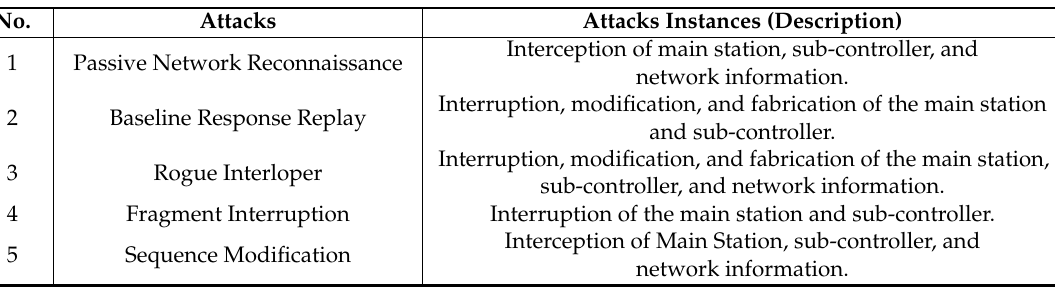
Table 1. Attack taxonomy for the DNP3 pseudo-transport layer.